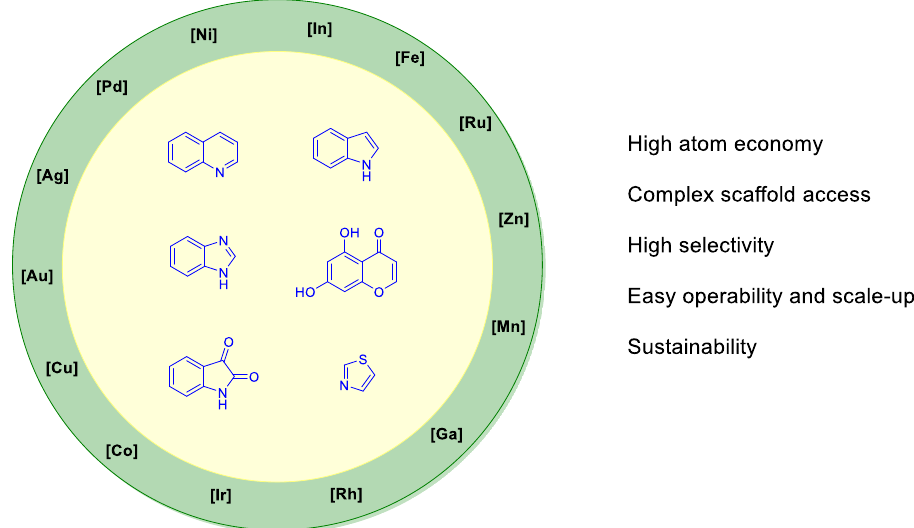
Figure 8. Key features of metal-promoted heterocyclization methodologies.